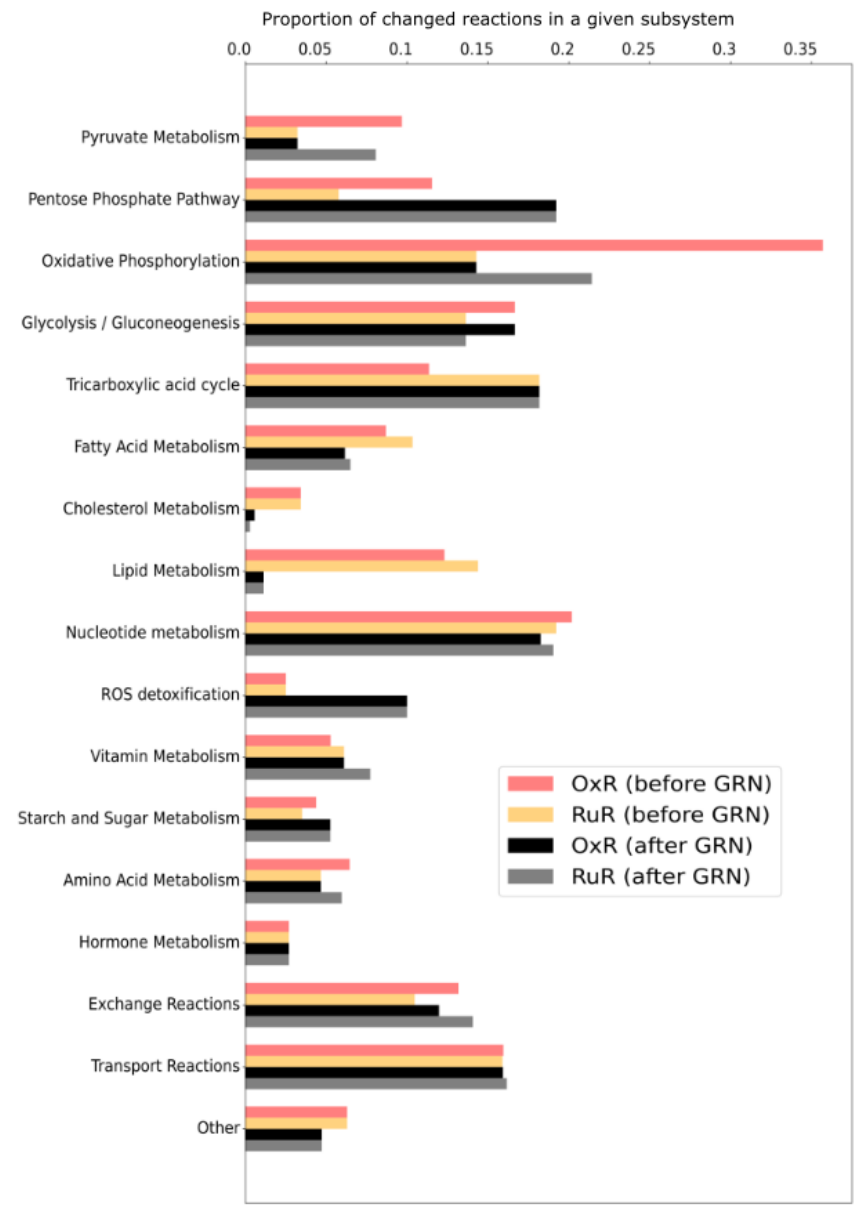
Figure 2. Metabolic fluxes in resistant versus sensitive models before and after growth rate normal- ization. Both intracellular and extracellular metabolite constraints were applied to generate four instances of the HCT-specific GSMM [oxaliplatin (OxR) and BOLD-100/KP1339 (RuR) and their parental sensitive counterparts (sensitive and sensitive-DMSO, respectively)] as described in the Section 2. A parsimonious thermodynamic flux variability analysis (pTFVA) was done on each model instance. Flux values of the resistant instances were compared to their respective controls. Metabolic reactions that had an absolute relative difference greater than 15% in both the highest possible and the lowest possible flux value were considered to be different. The proportion of reactions that show a difference in flux between the OxR and sensitive condition [OxR before growth rate normalization (GRN); red bars] and the RuR and sensitive conditions (RuR before GRN; orange bars) are shown for each subsystem (pre-defined pathways in the GSMM). All flux values were then normalized according to the corresponding growth rate of that condition (Figure S1) and were again checked for a relative difference between OxR (OxR after GRN; black bars) and RuR (RuR after GRN; gray bars) and their sensitive controls. Subsystems for which no relative changes in flux between resistant and sensitive instances were observed were omitted from the figure for